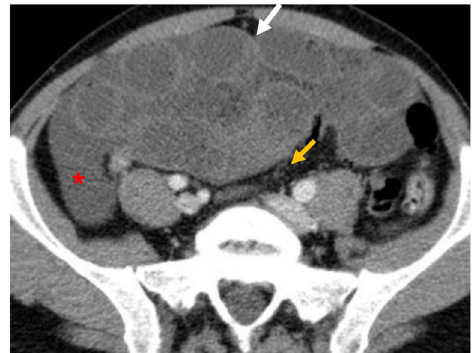
Fig.6 Gaslessabdomen. Contrast-enhancedCTimage ofthe abdomen in a 62-year-old female with small bowel wall ischaemia due to venoocclusive disease. Contrast-enhanced CT image of the abdomen shows dilated and mainly fluid-filled bowel loops and gasless abdomen (white arrow). Ascites (*) and vascular engorgement (orange arrow) are also seen